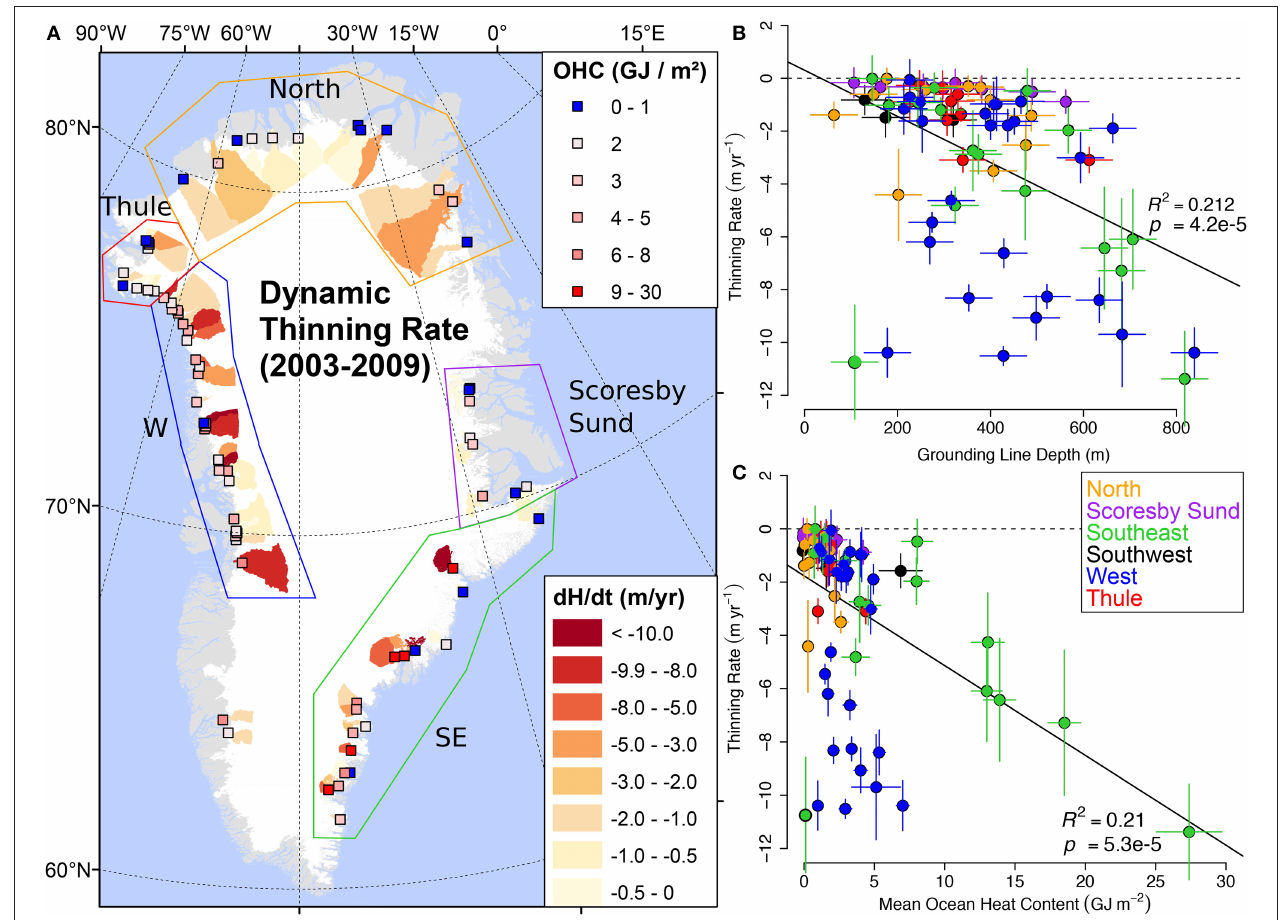
FIGURE 4 | (A) Dynamic thinning rates (2003–2009) for all 74 glaciers with known grounding line depths are shown in Figure 1 along with OHC from ECCO2 model (colored boxes). OLS regression results for annualized dynamic thinning rates ( m yr − 1 ) with (B) grounding line depths (m) and (C) mean OHC ( GJ m − 2 ) for all 74 tidewater glaciers. Also indicated is the global coefficient of determination. Regional regression groupings are annotated.